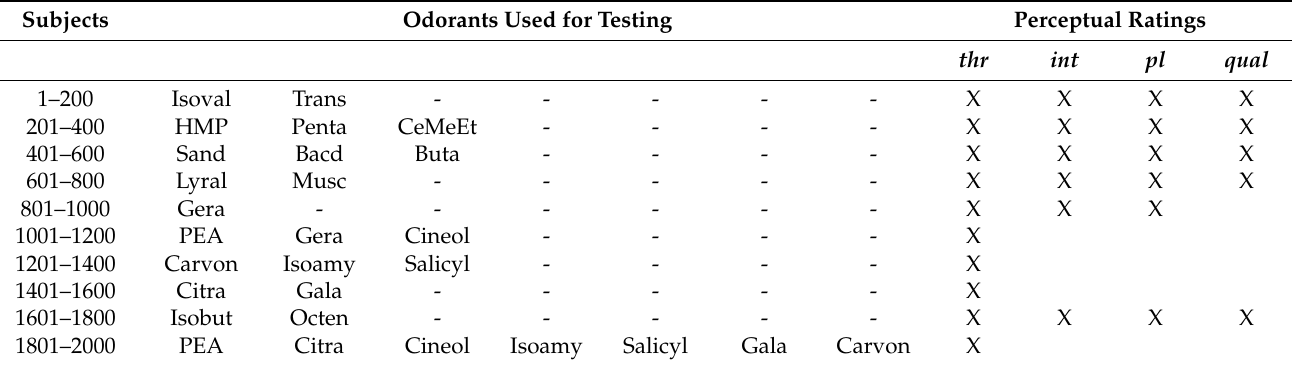
Table 2. Overview of Subject Groupings, Odorants and Perceptual Ratings